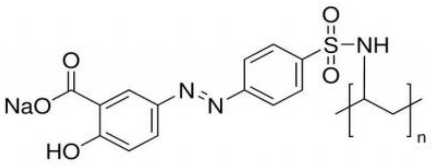
Figure 1. Chemical structure of the poly(1-(4-(3-carboxy-4-hydroxyphenylazo)benzenesulfonamido)- 1,2-ethanediyl) (PAZO) polymer.